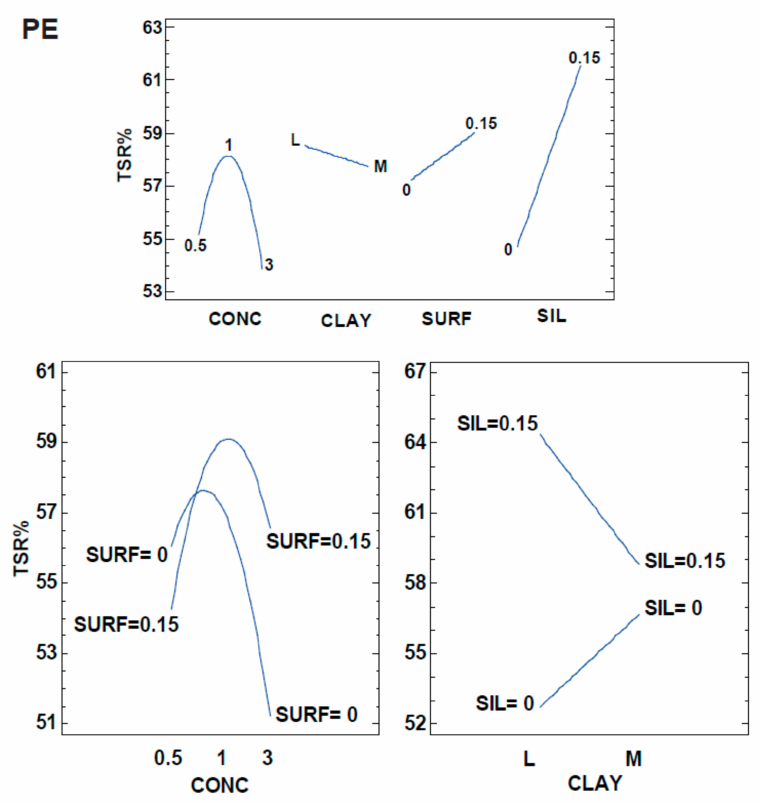
Figure 14. Main effects and interactions plots from the TSR (%) response in the PE